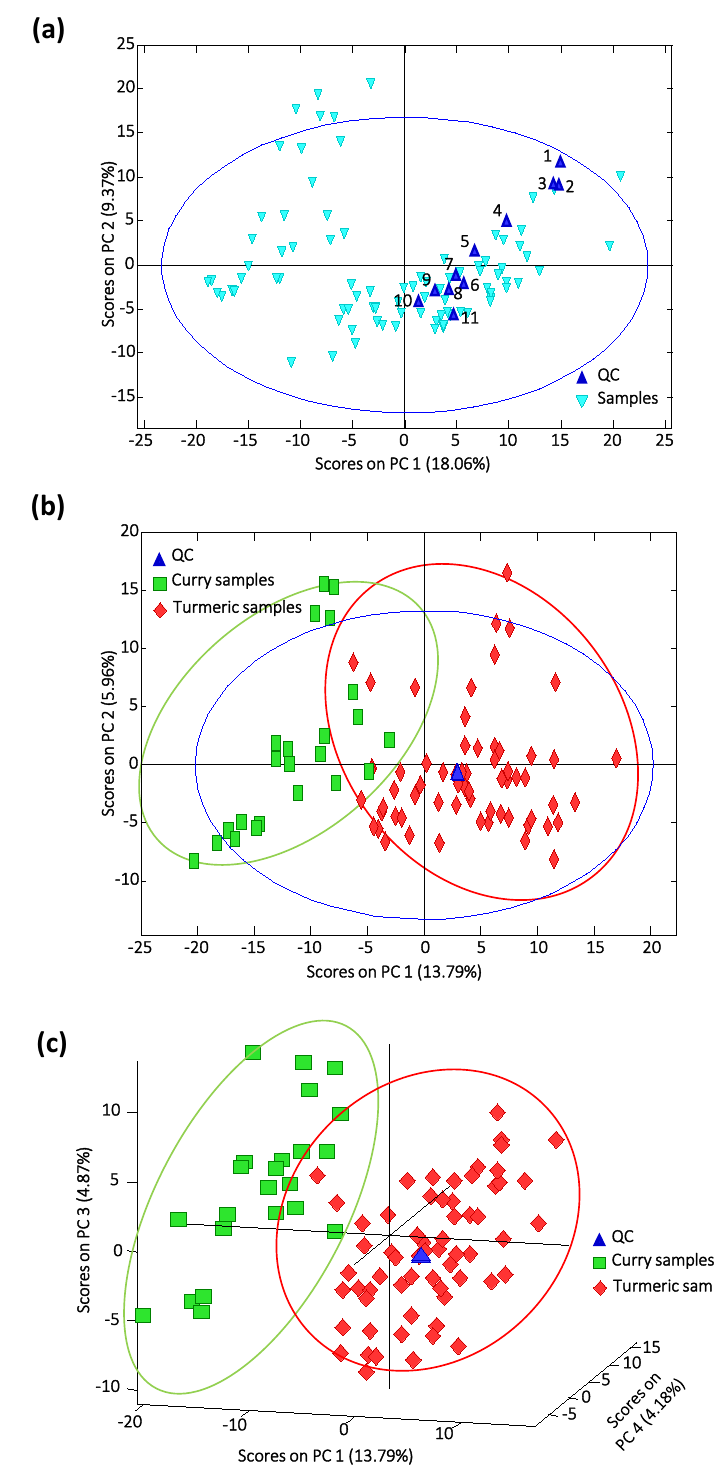
Figure 3. Study of turmeric and curry samples by principal component analysis (PCA). ( a ) Score plot of PC1 vs. PC2 when using non-normalized UHPLC-HRMS fingerprints as chemical descriptors. ( b ) PCA score plot of PC1 vs. PC2 using normalized data to build the model. ( c ) PCA score plot of PC1 vs. PC3 and PC4 when using corrected UHPLC-HRMS fingerprints.